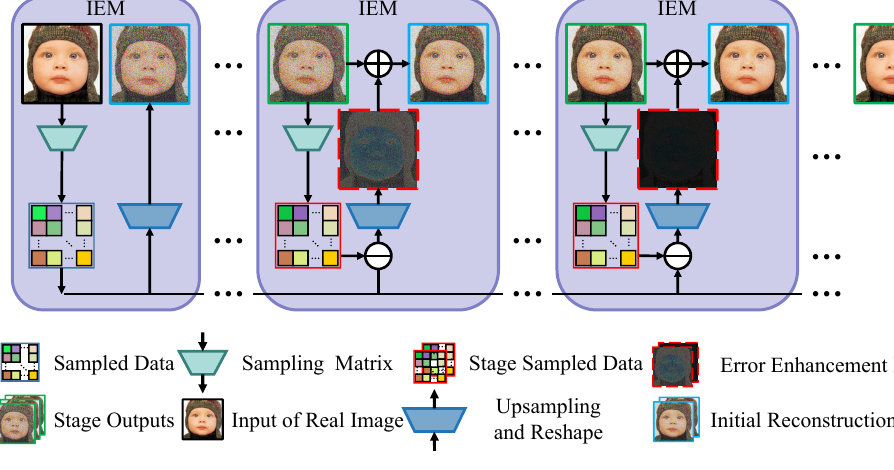
Figure 5. The flow chart of IEM.